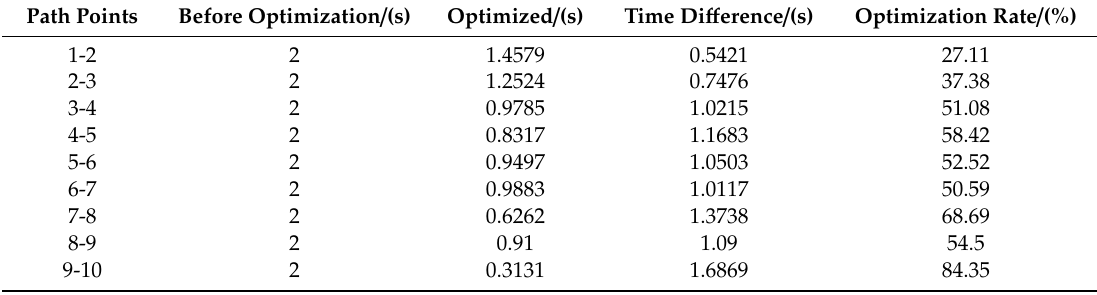
Table 9. Comparison of time optimization results in obstacle environment.